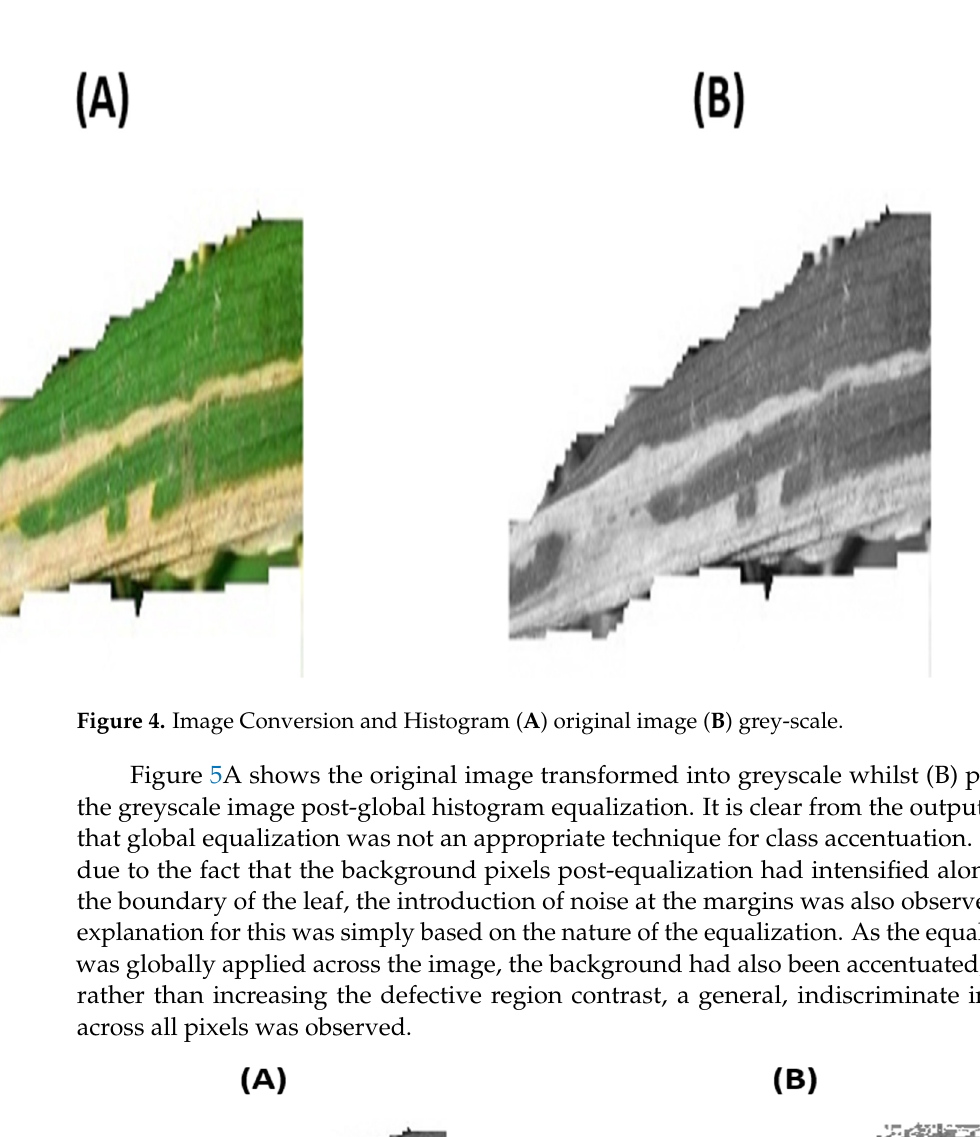
Figure 5. Global Equalization: ( A ) original greyscale; ( B ) post-equalization.